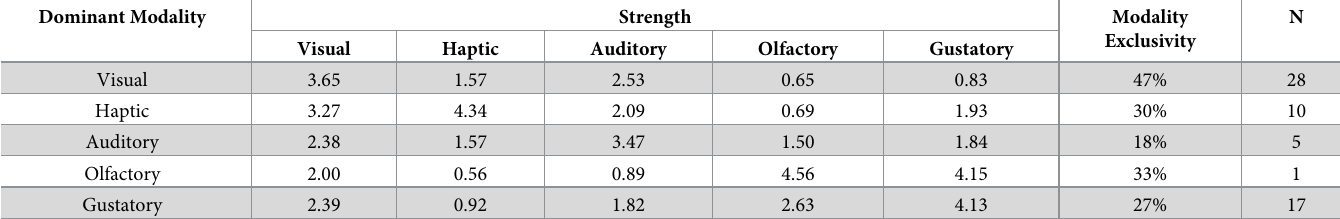
Table 7. Mean strength rating (0–5) on the five modalities, modality exclusivity scores, and number of the disyllabic words per dominant modality. Dominant